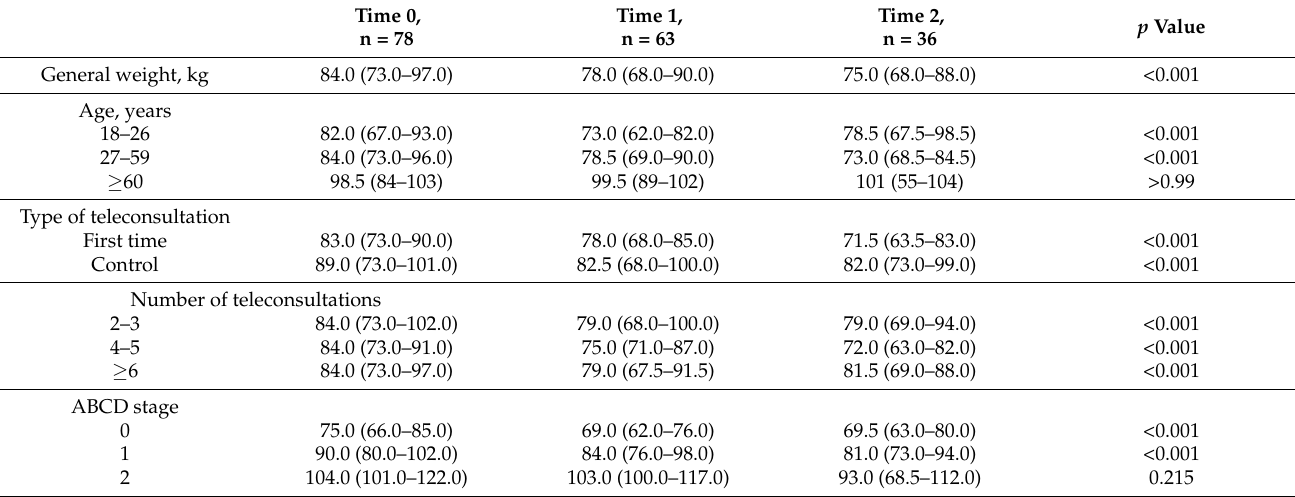
Figure 2. Box plot graphic showing the median and interquartile range of weight at each time point. Table 4. Comparison of weight (kg) at each time point analyzed by age, type, and number of teleconsultations, and ABCD